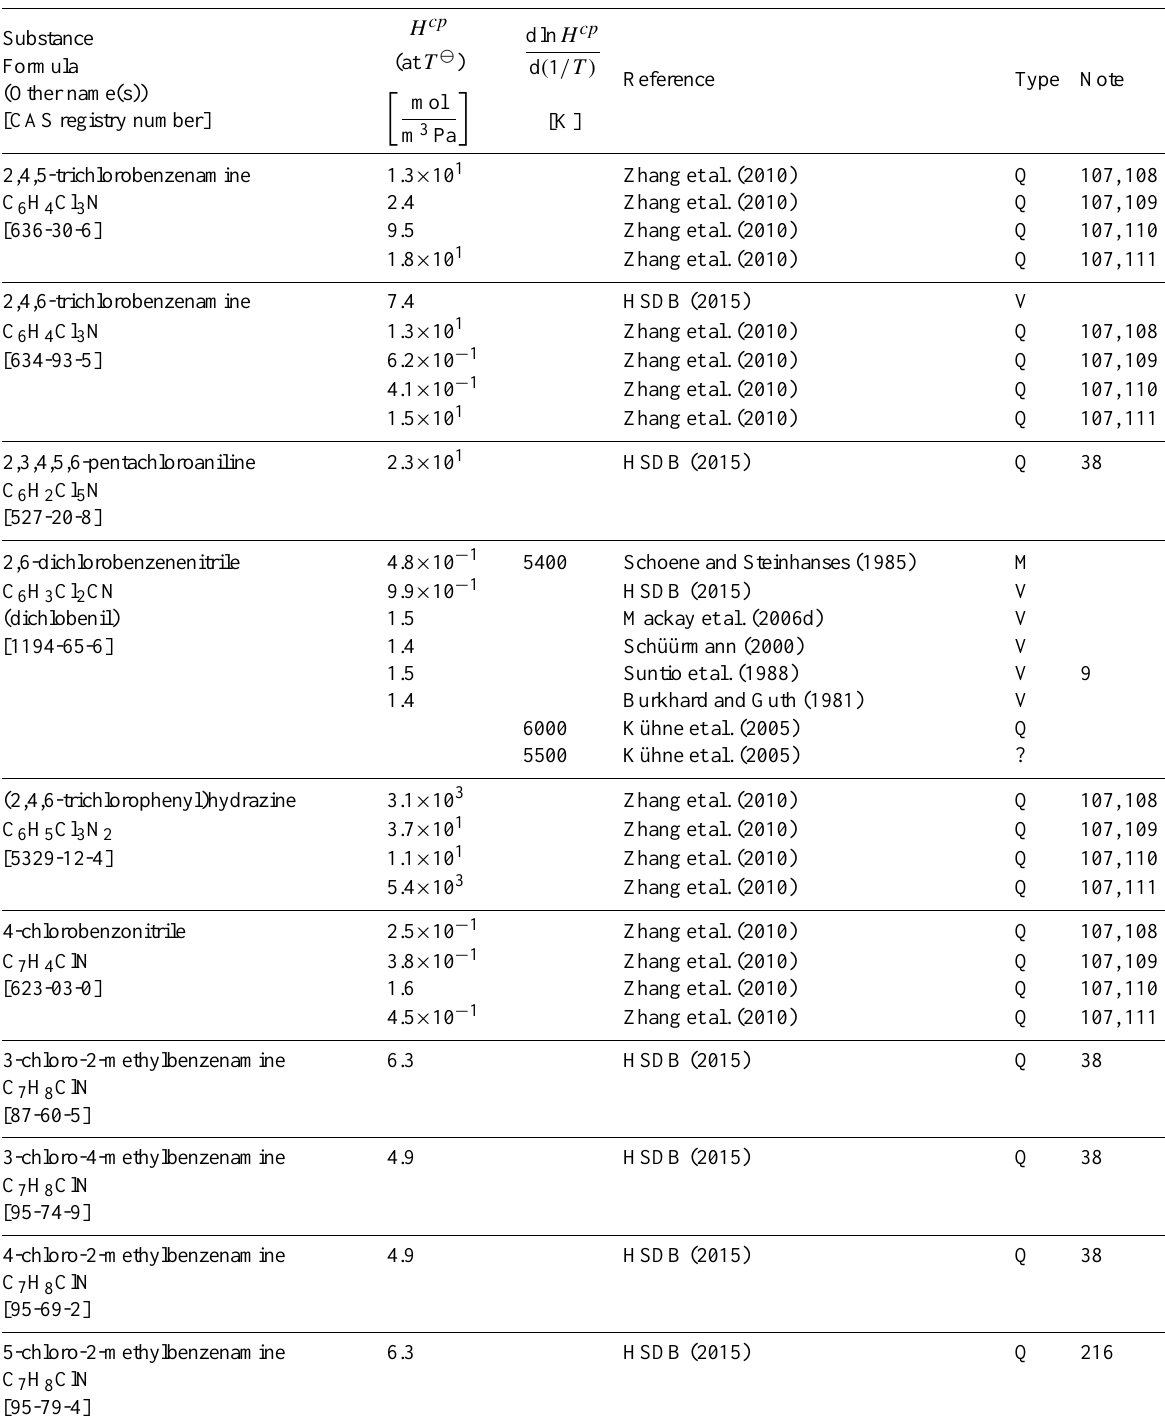
Table 6: Henry’s law constants for water as solvent